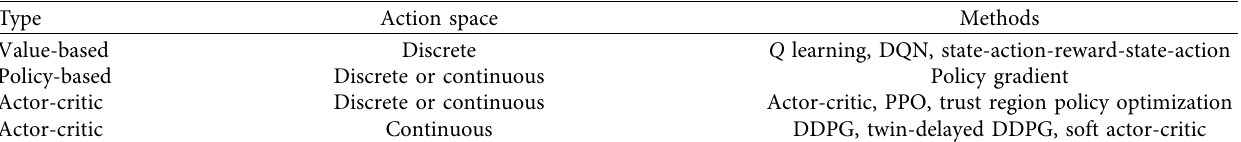
Table 1: Te classifcation of deep reinforcement learning methods.